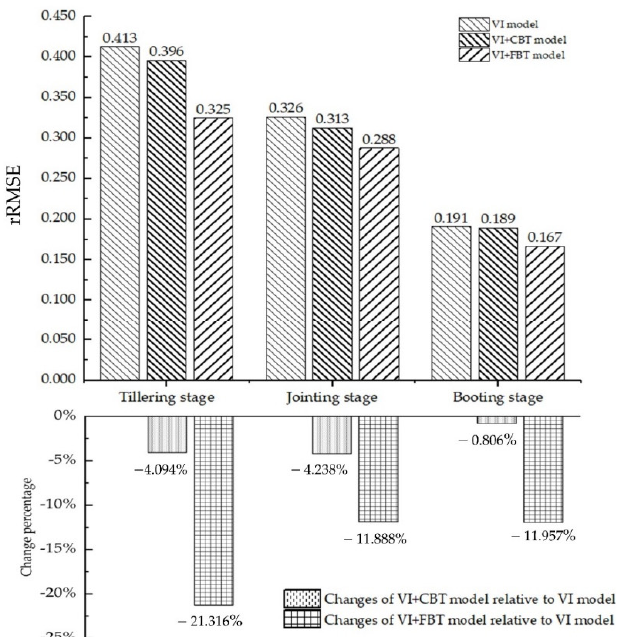
Figure 7. The rRMSEs of estimated AGB using VI model, VI+CBT model, and VI+FBT model under growth stages and the percentage changes of VI+CBT model and VI+FBT model relative to VI model (note: the presented values were rounded to three decimals for the sake of